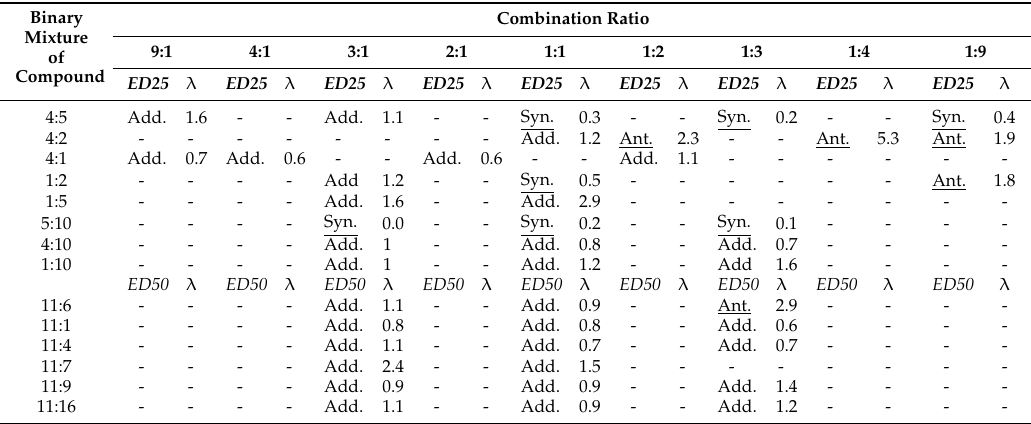
Table 4. Types of interactions with Student’s t test ( α = 0.1) and interaction index ( λ ) between the different combinations of binary mixtures of isolated compounds from Citrus sinensis in the etiolated wheat coleoptile bioassay (Add.: additive; Syn.: synergistic; Ant.: